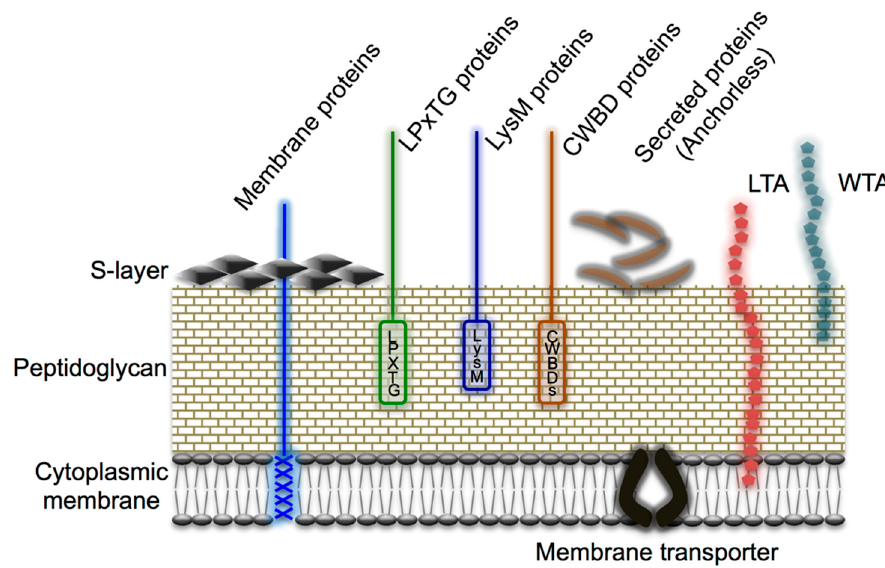
Figure 4. Cell-surface architecture of Gram-positive bacteria. A thick, multilayered peptidoglycan layer is decorated with lipoteichoic acid (LTA), wall teichoic acid (WTA), and various proteins, including S-layer proteins. Cell wall-anchored proteins are attached to the cell wall either (i) covalently by sortases (e.g., LPXTG proteins) or (ii) non-covalently (e.g., through a LysM motif or cell wall-binding domains [CWBDs]). Membrane proteins can covalently attach to the long-chain fatty acids of the cytoplasmic membrane, whereas S-layer proteins are attached to the cell wall through charged or uncharged secondary cell wall polymers. Reproduced from Desvaux et al. [67] with several modifications.